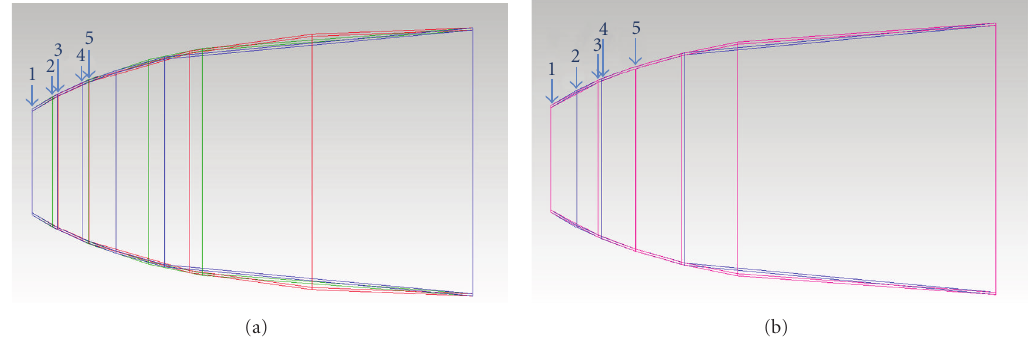
Figure 8: (a) Point-approximated CPC (red), tangent-approximated CPC (green), and power-approximated CPC (blue). Superimposed vertical lines are present at positions corresponding to labels 3 (red and blue) and 5 (green and red). (b) Power-approximated CPC (blue) and corrected power-approximated CPC (pink). Superimposed blue and pink vertical lines are present at the position corresponding to label 5.